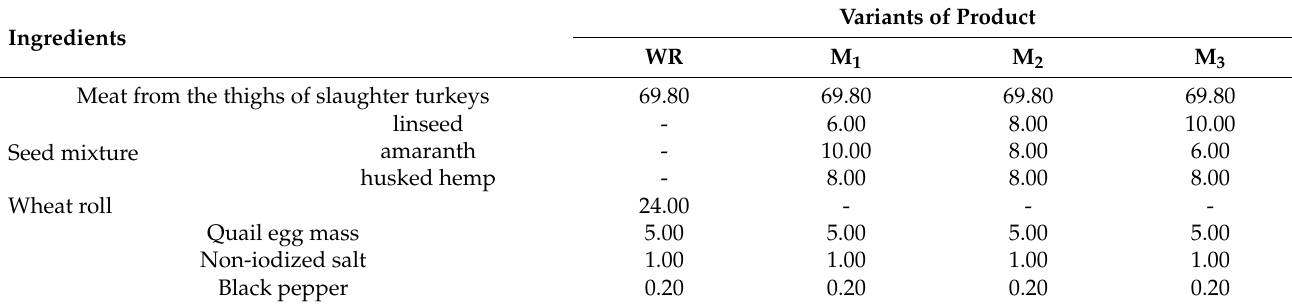
Table 1. Recipe composition of poultry meatballs